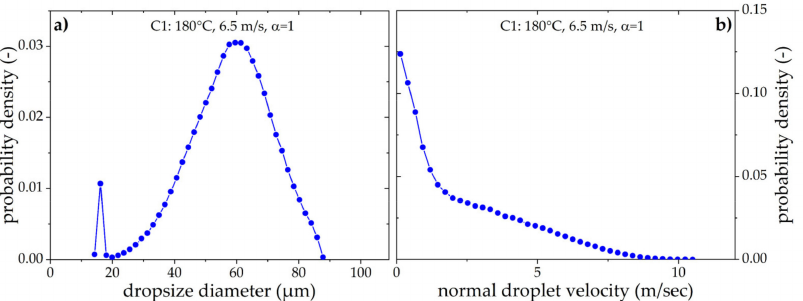
Figure 13. Distribution of impinging droplets: ( a ) diameter size and ( b ) velocity normal to the wall.